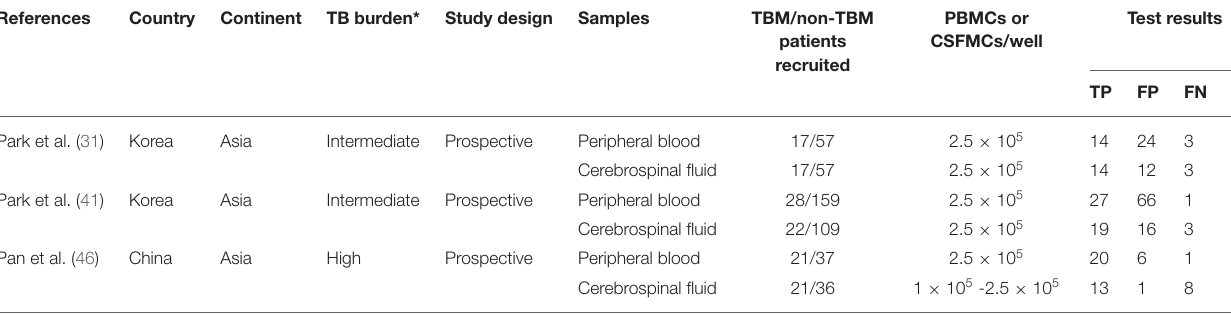
TABLE 4 | Summary characteristics of studies comparing confirmed TBM with non-TBM.